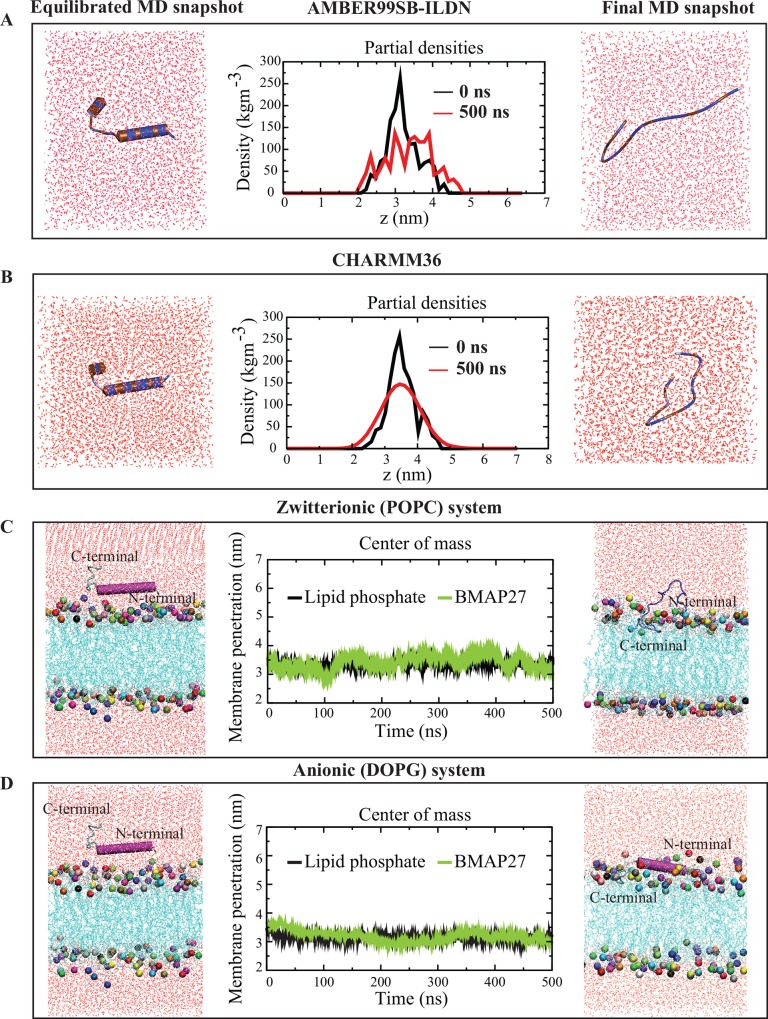
Conformational analysis of BMAP27 in aqueous and model lipid-bilayer environments.BMAP27 folding studied in (A) AMBER99SB-ILDN, and (B) CHARMM36 force field on a 0.5 μs time scale. The peptide and solvent molecules are represented as schematic and lines in Discovery studio visualizer 3.5, respectively. The peptide is colored by its hydrophobicity where hydrophobic and hydrophilic residues are shown as brown and blue, respectively. The partial density changes across the corresponding simulation boxes are shown in the central column. The z-coordinate represents the peptide position inside the simulation box. BMAP27 interaction with (C) zwitterionic (POPC), and (D) anionic (DOPG) membrane model systems. The peptide conformation is shown as a cartoon, lipid in blue line and water as red lines in VMD program. The relative BMAP27 membrane penetration is calculated by plotting the center of mass of peptide and lipid head phosphates present in the outer leaflets.